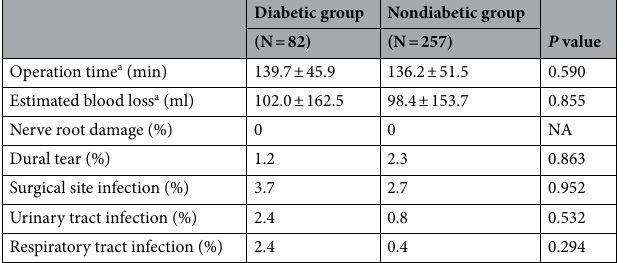
Diabetic group Nondiabetic group